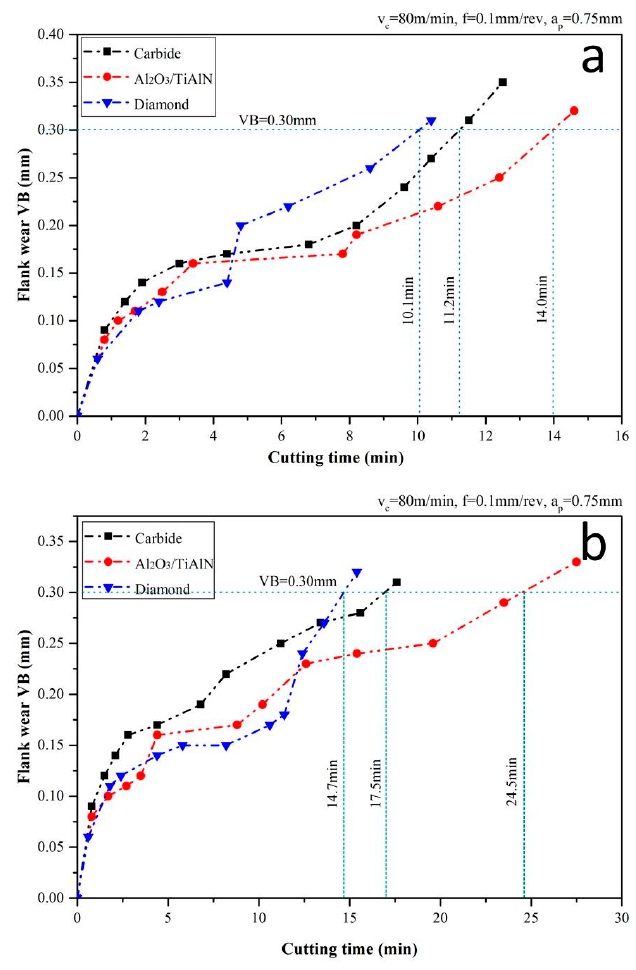
Figure 9. Tool wear under dry ( a ) and MQL ( b ) condition.